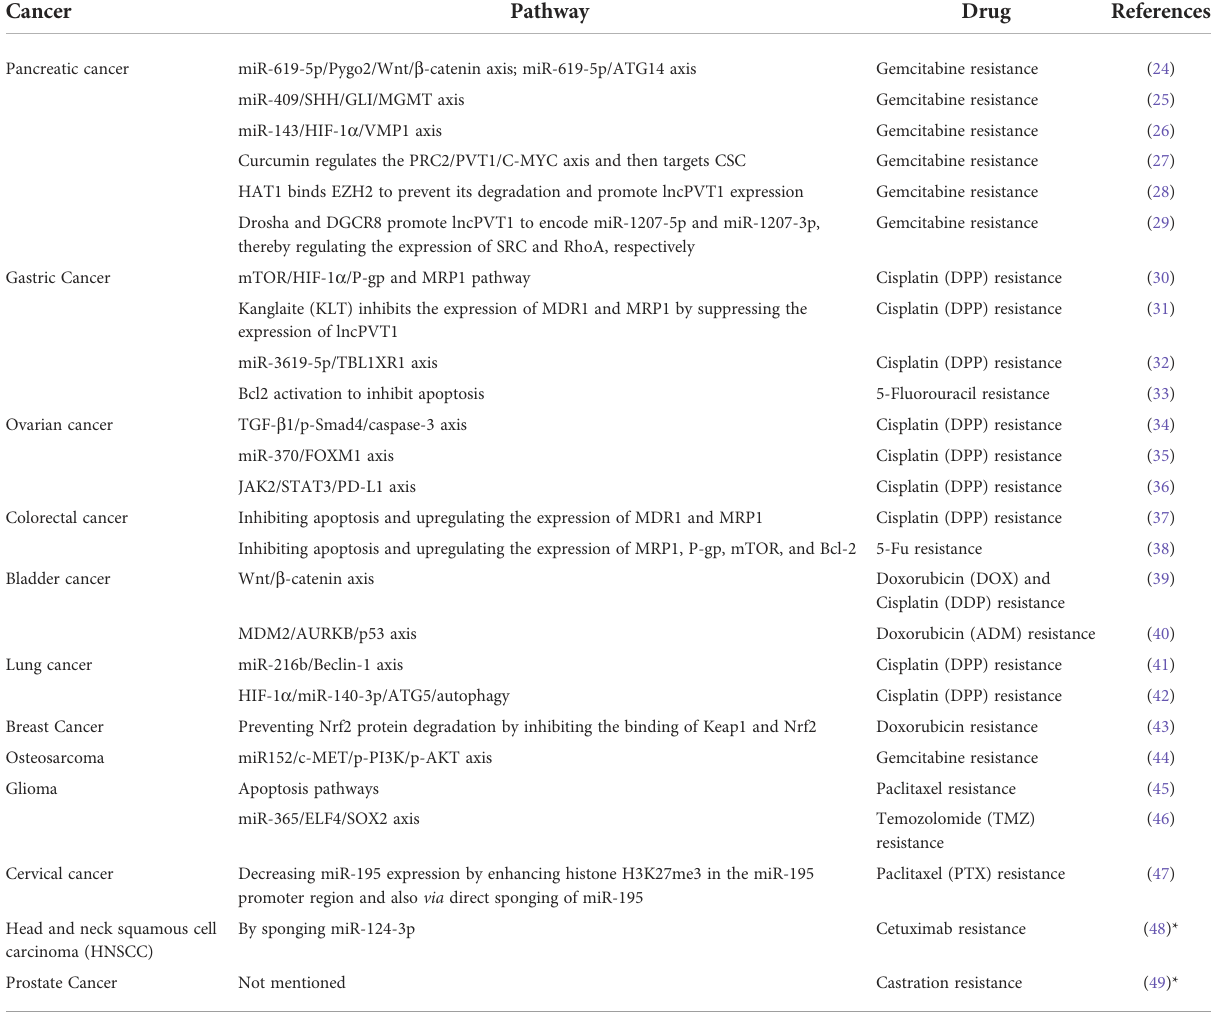
TABLE 1 Molecular mechanisms underlying the lncPVT1-induced regulation of drug resistance. Cancer